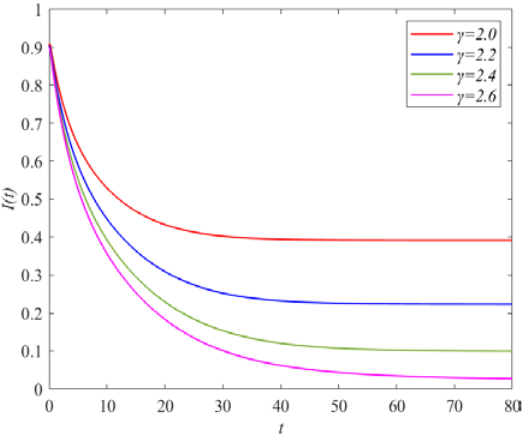
Fig. 5. Evolution of honeypots with different node degree values.